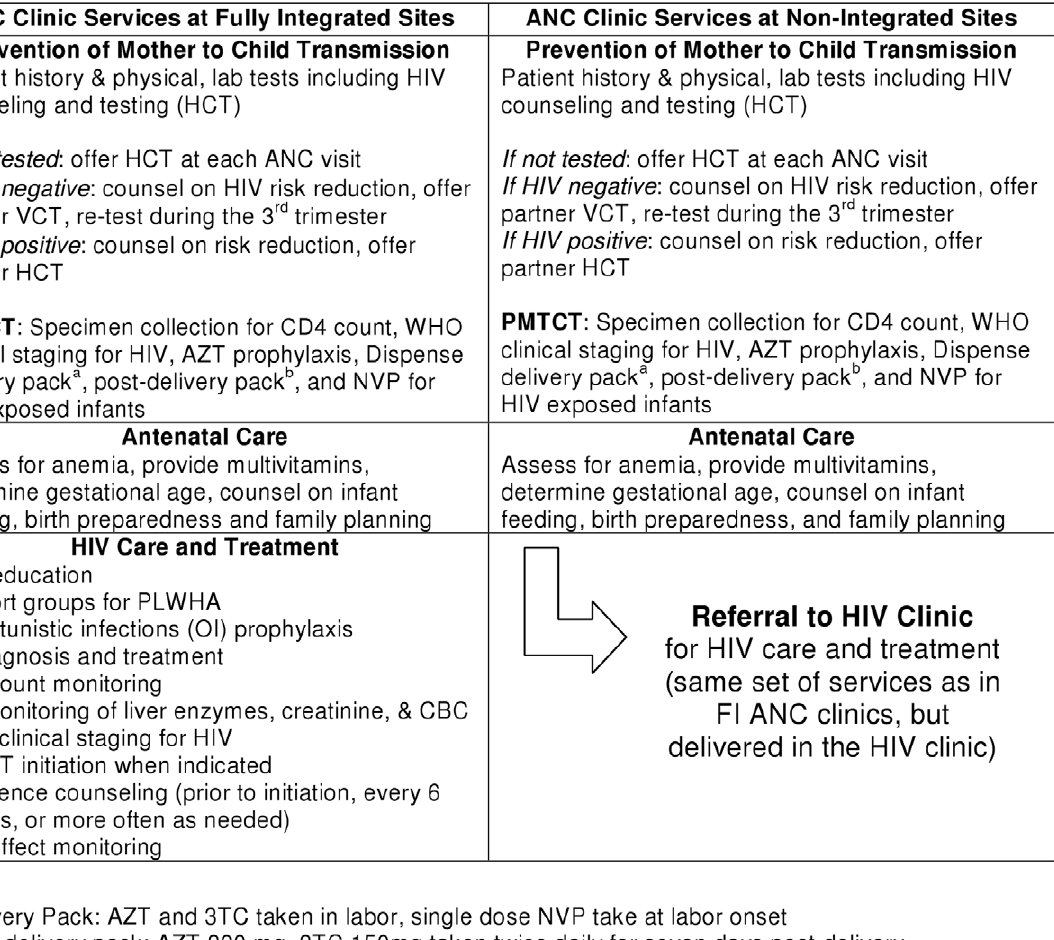
Figure 4. Clinical services provided in the ANC Clinic at Fully Integrated sites and Non-Integrated sites. ANC, PMTCT, and HIV services available at the Fully Integrated sites and Non-Integrated sites based on Kenyan National guidelines.